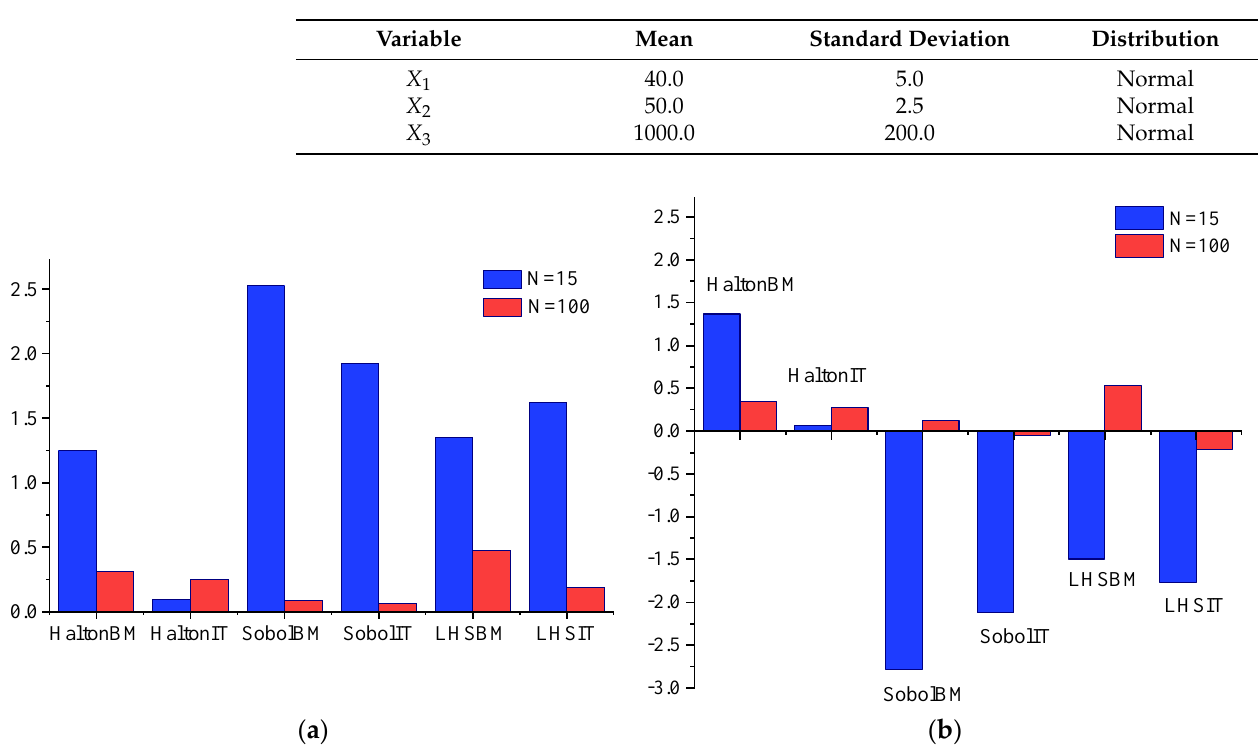
Figure 4. Maximum relative errors of sensitivity and failure probability when N = 15 and 100 in Example 1. ( a ) Maximum relative errors of sensitivity (%); ( b ) Maximum relative errors of failure probability (%).